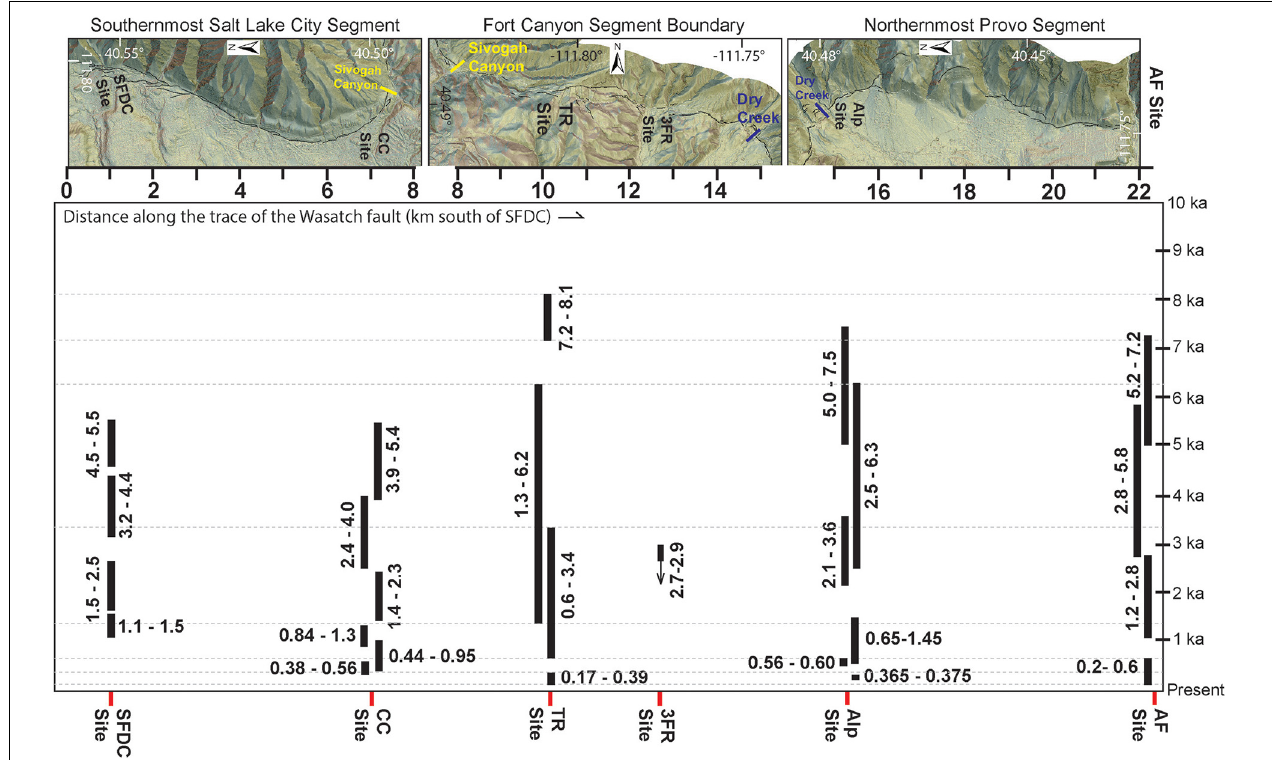
FIGURE 8 | Space-time paleoseismic diagram extending along the southernmost Salt Lake City segment of the Wasatch fault zone, across the Fort Canyon segment boundary and the northernmost Provo segment. Distance is measured in kilometers along the fault trace south of the South Fork Dry Creek site (SFDC site). The fault trace mapping over combined digital hillshade and continuous three color aspect imagery (Toké et al., 2017) is rotated through the segment boundary bends to form a roughly linear scale and depict the approximate location of paleoseismic sites along the fault trace for the space-time graph. In addition to the TR site (this study), paleoseismic data have been collected from five other sites along this ∼ 23 km long reach of the Wasatch fault zone: the South Fork Dry Creek site (SFDC: Schwartz and Lund, 1988; Black et al., 1996), the Corner Canyon site (CC site: DuRoss et al., 2018), the Three Falls Ranch site (3FR site: Western GeoLogic, 2004), the Alpine site (Alp site: Bennett et al., 2018), and the American Fork site (AF site: Forman et al., 1989). Holocene event age constraints from each site, presented in thousands of years before present (ka) with 2 σ confidence bounds (rounded to the nearest 0.1 ka), are plotted for comparison among sites. Gray dashed lines extend from the event age bounds of the TR site to facilitate comparison. It is important to note that the 3FR site was a consultancy investigation; the event data from this site are incomplete, and the one event plotted is only constrained with a stratigraphic age prior to that